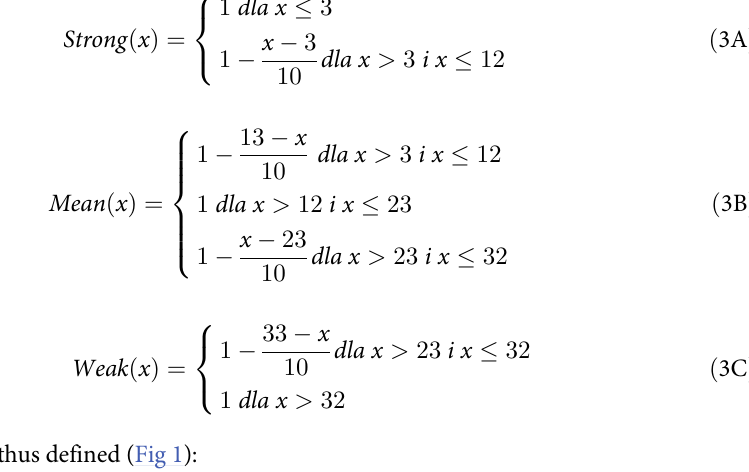
PLOS ONE | https://doi.org/10.1371/journal.pone.0271340 July 26,